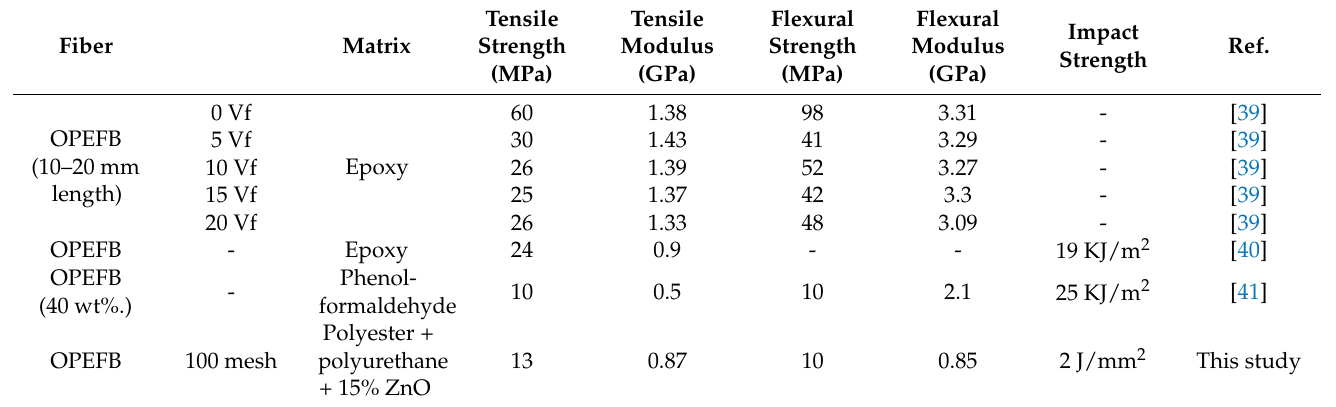
Table 1. Comparison of the current findings with previous